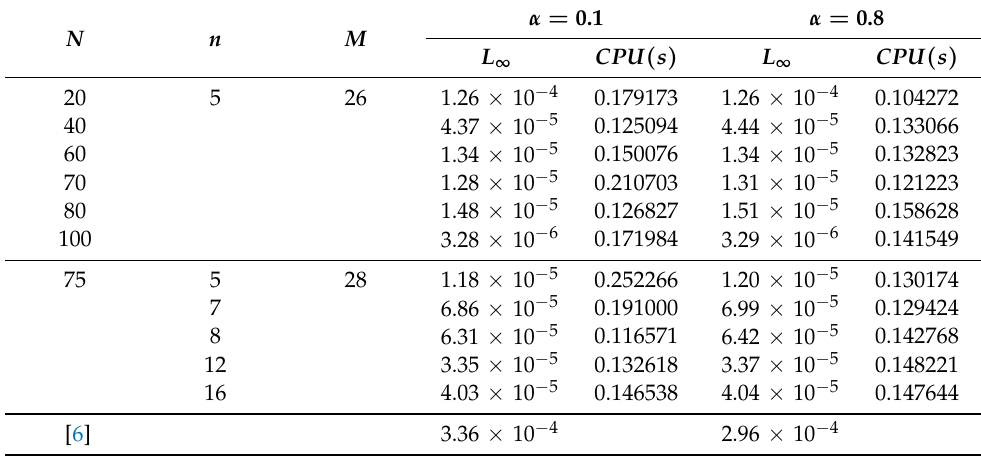
Table 2. The approximate solutions for 10 12 < κ < 10 16 , and ξ ∈ [ 0,1 ] , and t = 1, corresponding to Problem 2.